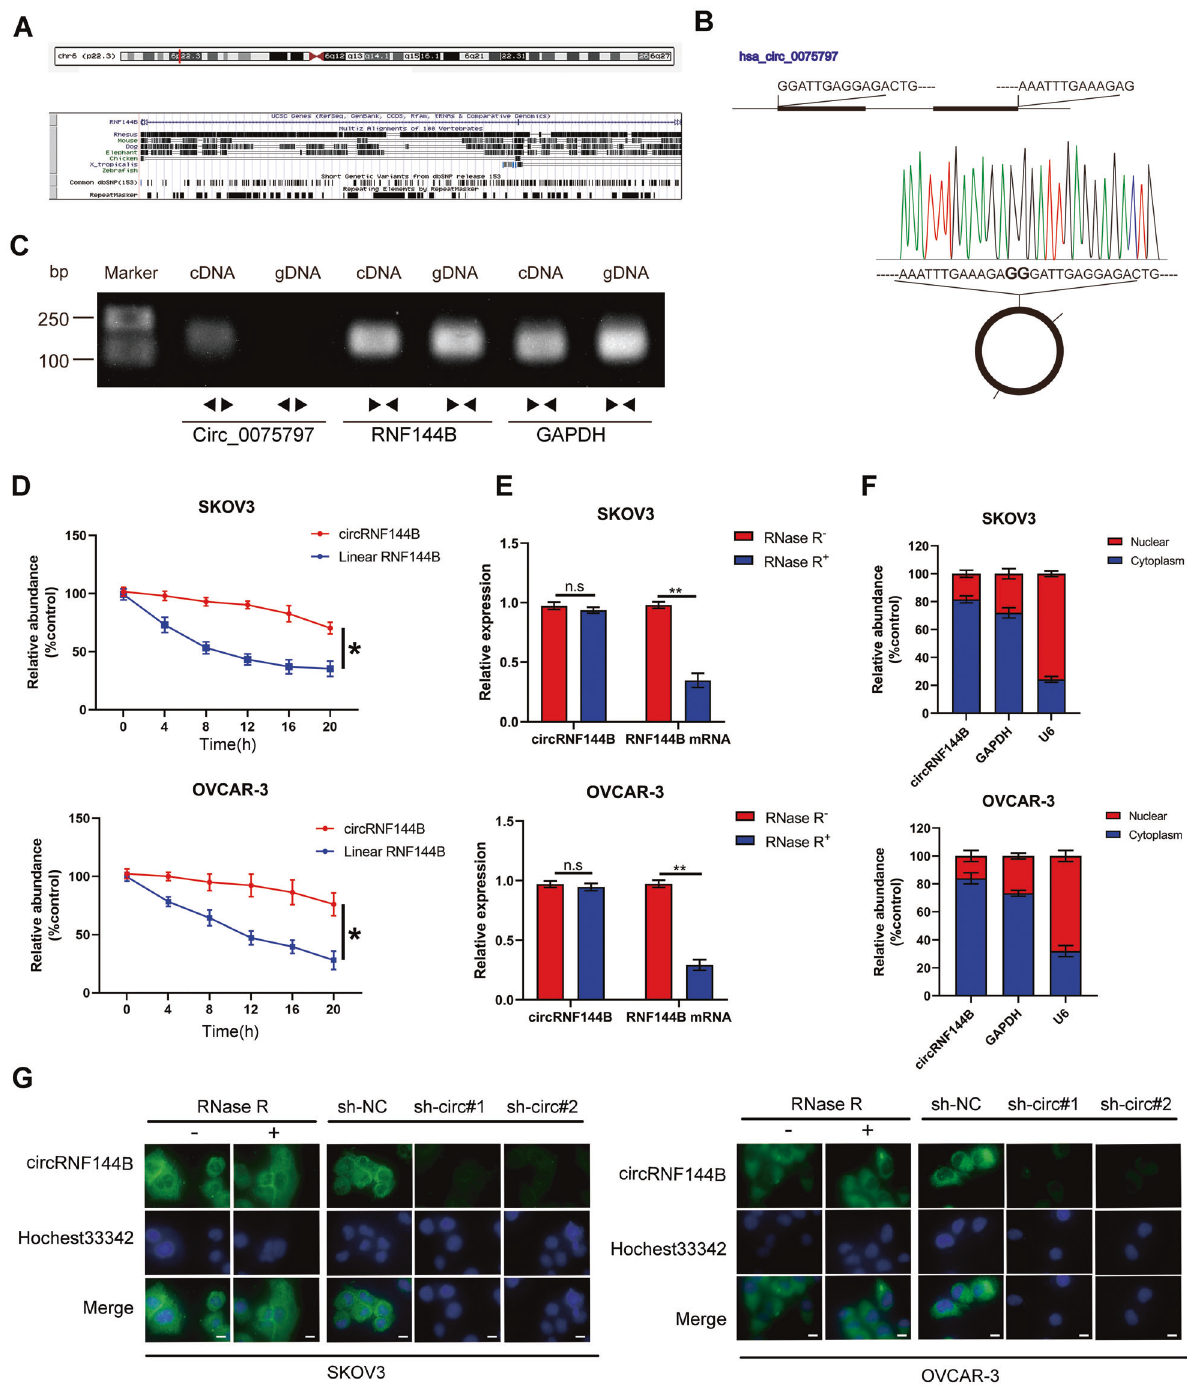
Fig. 2 CircRNF144B was veri fi ed as a cytoplasmic circRNA. A CircRNA annotation in the circBase database indicated that circRNF144B is located on chromosome 6, contains 367 bp, and derives from the host gene RNF144B. B Sanger sequencing veri fi ed the head-to-tail splicing of circRNF144B. C Nucleic acid electrophoresis indicated that circRNF144B was ampli fi ed by divergent primers in the cDNA, but not in the gDNA. D qRT-PCR results indicated that the mRNA stability of circRNF144B was higher than that of linear RNF144B. E qRT-PCR results indicated that circRNF144B exhibited resistance to RNase. F – G Nuclear-cytoplasm separation and FISH assays indicated that circRNF144B was located in the cytoplasm. Scale bar, 25 μ m. **, P <